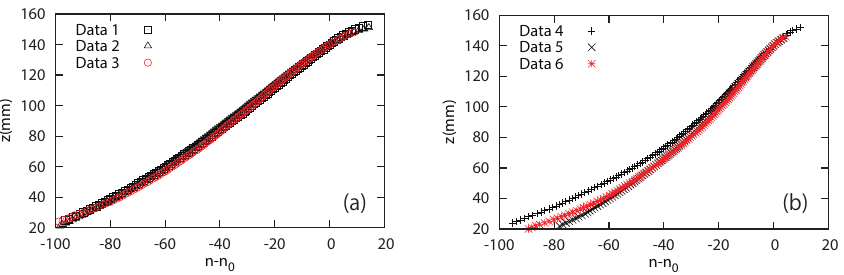
Figure 2. Rising motions obtained at f = 30 Hz and a = 70 m / s 2 on two di ff erent days with a cell with the copper back plate (Data 1 and 2, or Data 4 and 5) and on another day with a cell with an acrylic back plate (Data 3, or Data6). (a) Case of up-down cycles. (b) Case of down-up cycles.